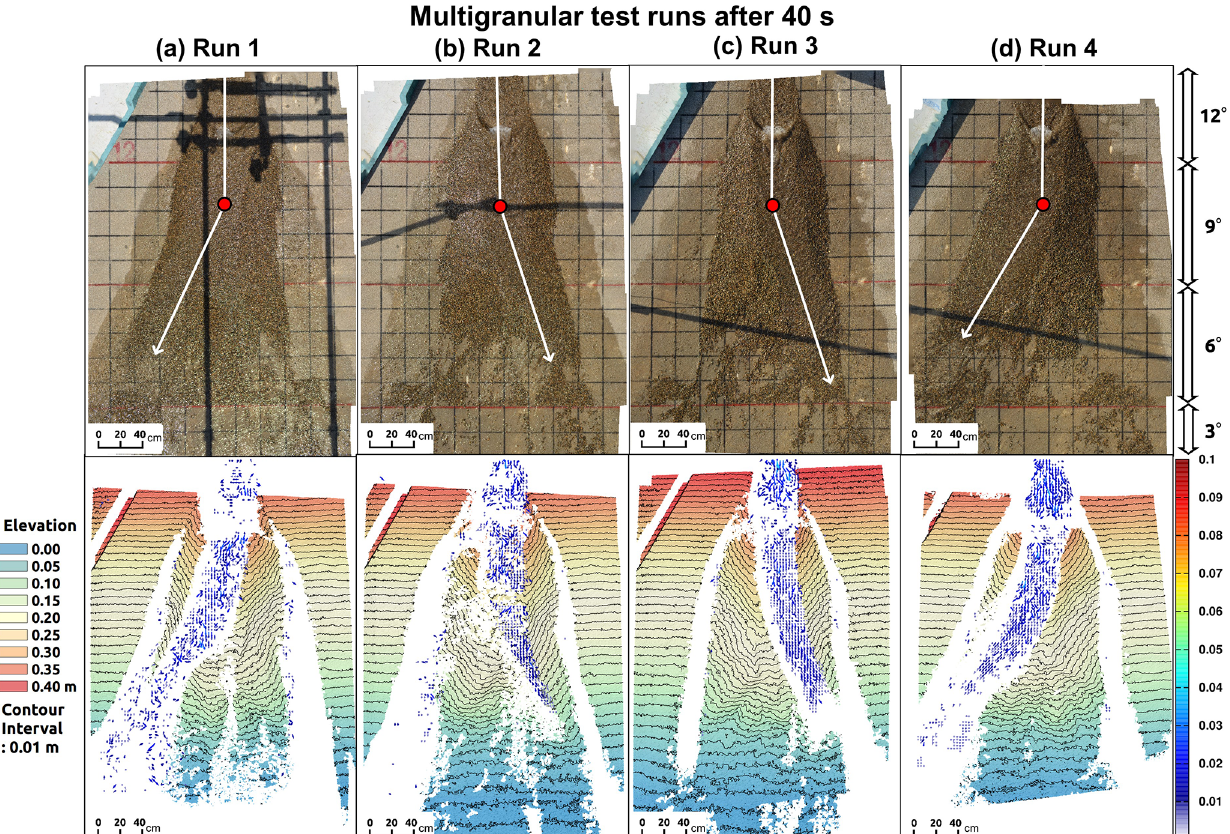
Figure 13. Fan morphology 40s after the start of runout of the multigranular flows. The upper and lower panels show orthophotos and digital elevation models (DEMs) with flow vectors, respectively. Respective sets of the upper orthophoto and lower DEM represent corresponding results of each experimental test run. The white arrows on the orthophotos indicate the assumed principal direction of flow descent. The red points in the orthophotos indicate the assumed occurrence point of the avulsion. The elevation of the DEMs is depicted assuming that the area with a 3 ◦ slope (i.e., the area furthest downstream from where the slope angle changed from a 6 to 3 ◦ slope) has elevation of zero.